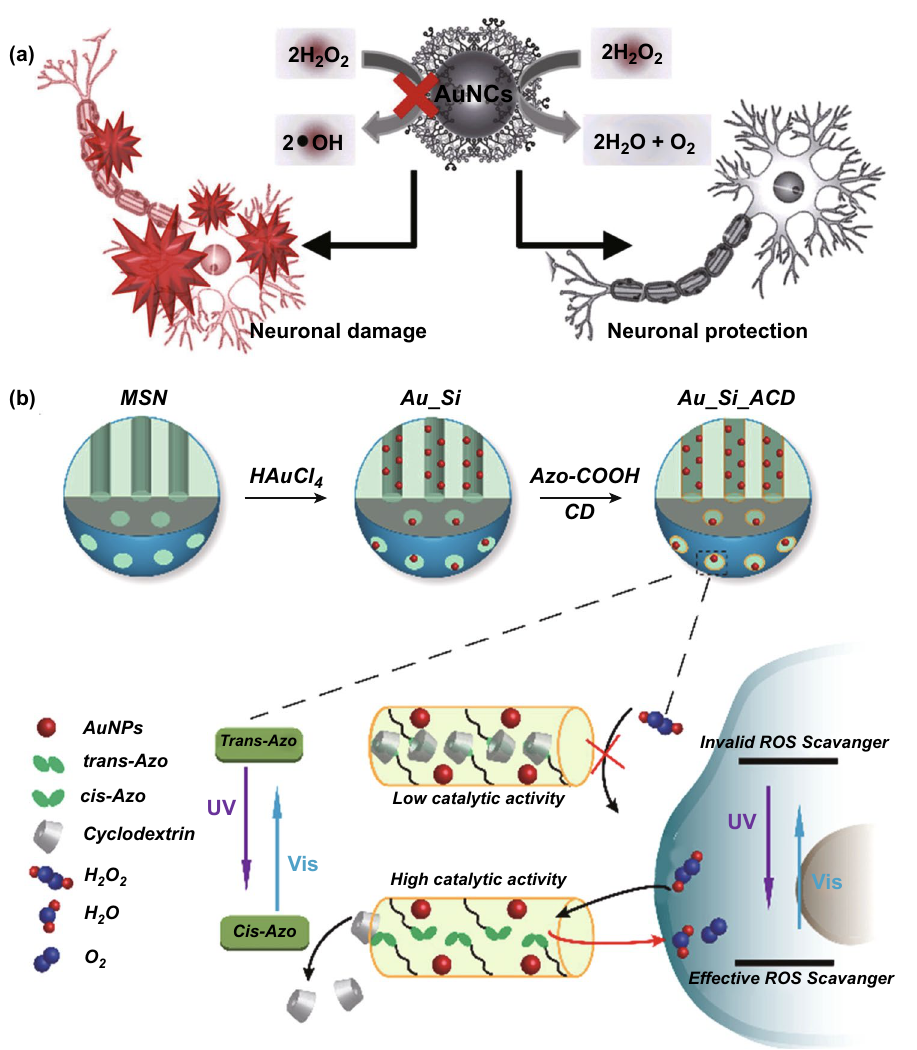
Fig. 10 Gold nanozymes used as ROS scavengers for cell protection. a Catalase‑like activity of amine‑terminated dendrimer‑entrapped AuNCs used for neuronal protection against oxidative damage [164]. Copyright 2016 Wiley–VCH Verlag GmbH & Co. KgaA. b Light‑mediated revers‑ ible modulation of ROS levels using mesoporous NPs loaded with AuNPs [163]. Copyright 2017 Wiley–VCH Verlag GmbH & Co.